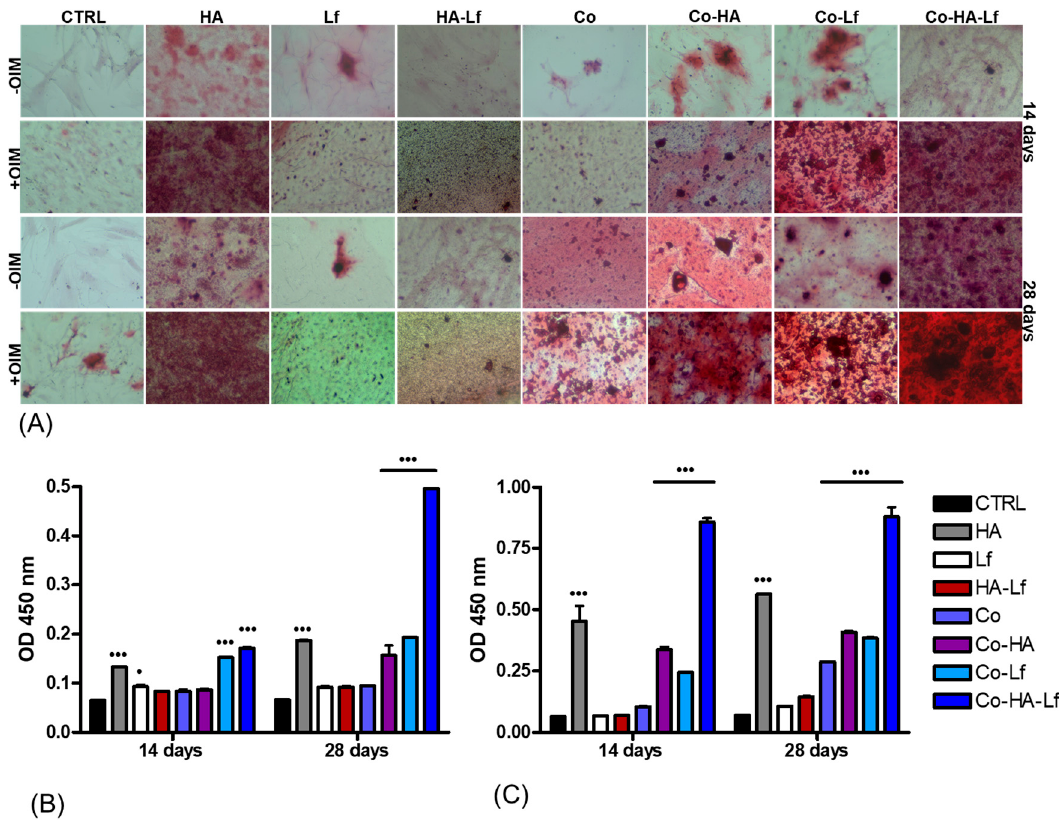
Figure 10. Alizarin Red labelling ( A ) of calcium deposits produced by hMSCs grown on different surfaces. Undifferentiated MSCs with no extracellular calcium deposits appear uncoloured or poorly coloured. The intense orange-red coloration represents the mineralised matrix. Colorimetric quantification of calcium production by hMSCs after 14 and 28 days of culture on analysed samples, in the absence ( B ), and in the presence of osteoinduction factors ( C ) Statistically significant values p < 0.05 and p < 0.001 vs control.